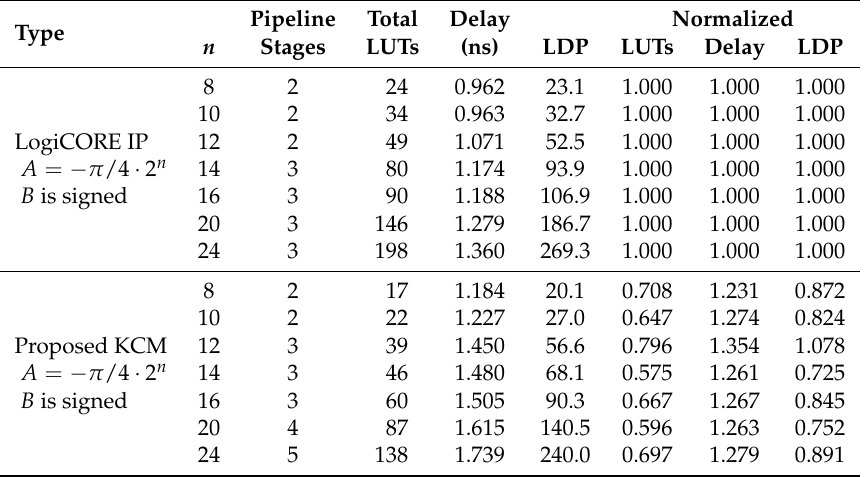
Table 6. Synthesis results for pipelined ( m × n )-bit KCMs, where m = n , A = − π /4 · 2 n and B is a signed variable. Proposed KCMs use 33% fewer LUTs and have a 14% lower LDP on average compared to LogiCORE IP KCMs.